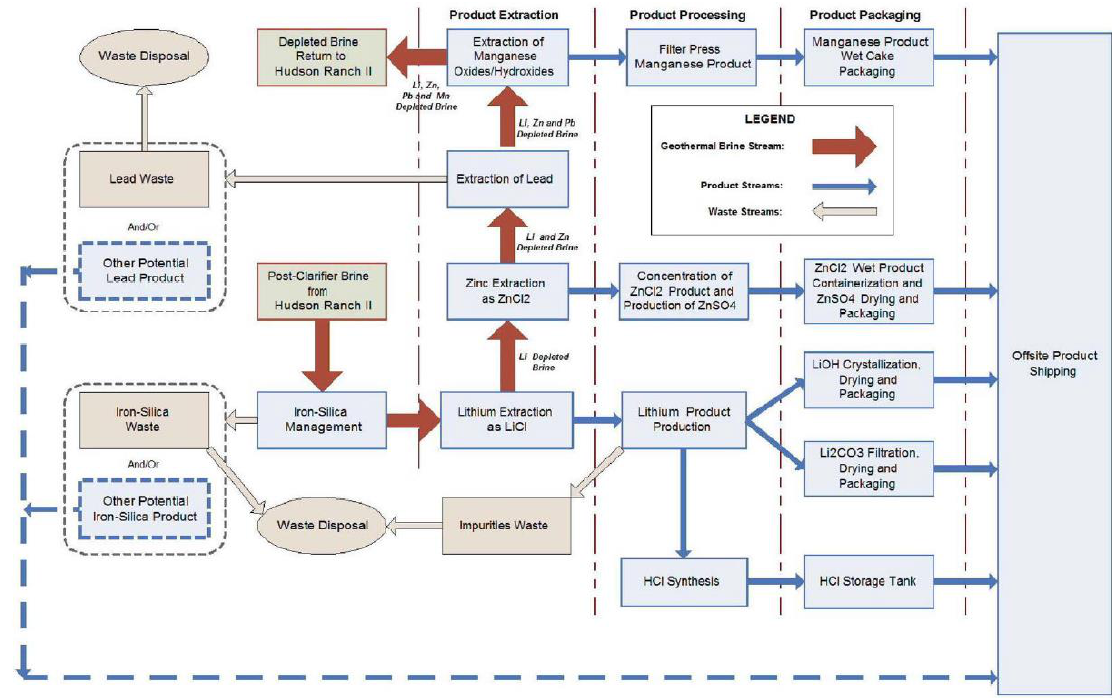
Figure 23. Simbol Hudson Ranch mineral management and recovery process [314]. Simbol conducted a major research project examining the extraction and recovery of minerals from geothermal brines that was funded by the US Department of Energy and the California Energy Commission [129,130]. The project was a wide-ranging investigation of multiple processes directly and indirectly related to extraction of lithium from geothermal brine [129,130]. Since the objective of the investigators was to develop intellectual property, including patents (Table 7), some key information is missing from the technical reports and one report is partially redacted [129,130]; however, the major activities of the project are described. Simbol, Inc. operated research and development (R&D) facilities in California, including (1) a laboratory and manufacturing facility in Pleasanton, where a pilot lithium extraction plant was tested against synthetic brines; (2) a skid-mounted pilot plant that was used to test lithium extraction from geothermal brines at the CalEnergy Elmore geothermal power plant and the EnergySource Hudson Ranch (John Featherstone) power plant; and (3) a pilot facility for lithium hydroxide and lithium carbonate production in Brawley, CA [129,130]. Activities conducted at these facilities are described below. Simbol also planned a larger R&D pilot plant facility at the EnergySource Hudson Ranch I geothermal power plant (Figure 23) [314]. This R&D facility was designed to receive brine flows of between 6 and 10 gallons per minute from the operating geothermal power plant and discharge treated brine that was depleted in silica, iron, lithium, zinc and manganese to an adjacent brine waste pond [320]. The facility planned to use scale inhibitors, flocculants, potable water, salt (sodium chloride), calcium hydroxide, soda ash (sodium carbonate), hydrochloric acid and sodium hydroxide [320]. The intention was for this facility to be operated as a commercial business [321,322]. Field pilot tests of a direct lithium extraction process were conducted by Simbol at two geothermal power plants in the Salton Sea KGRA [129,130]. A skid-mounted pilot plant was initially built and tested using synthetic solutions at the Pleasanton facility and